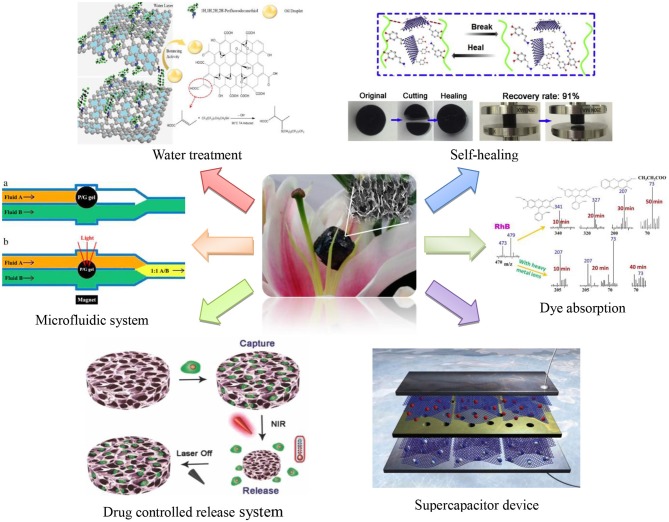
Applications of GBH.